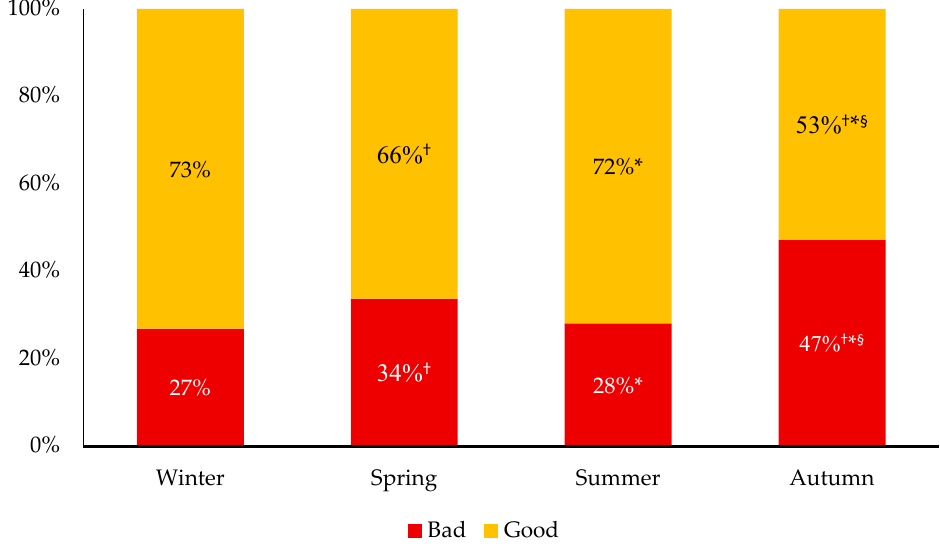
Figure 5. Evolution of sleep quality from the winter 2020 to the autumn 2020. † Significantly different from the winter; * significantly different from the spring; § significantly different from the summer; p < 0.001.